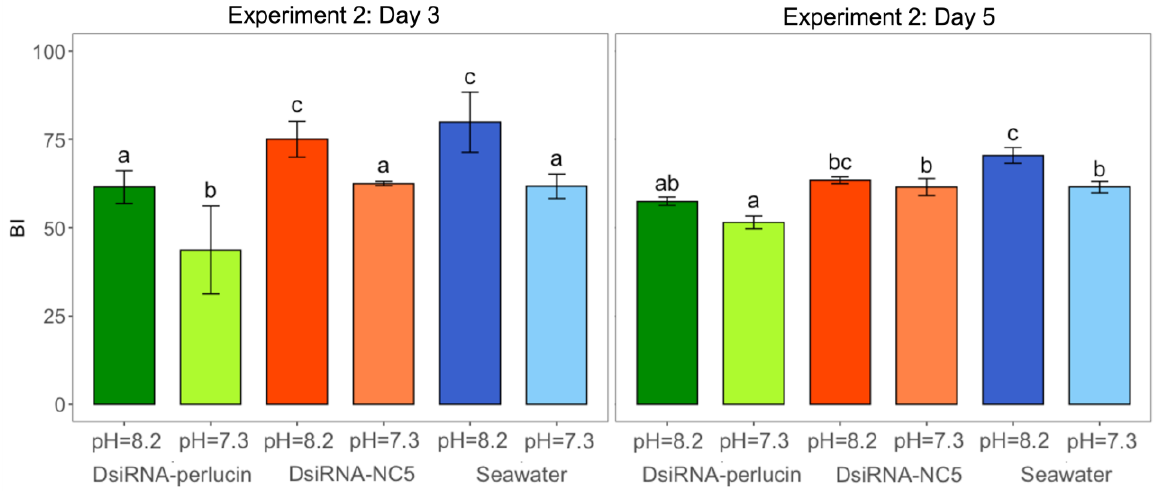
Figure 7. Shell birefringence index (BI, mean ± sd) among silenced (DsiRNA-perlucin (green)) and control (DsiRNA-NC5 (orange) and seawater (blue)) oysters cultured under different p CO 2 treatments (lighter shades for pH=7.3 and darker for pH=8.2) of oyster larvae from Experiment 2. BI was used as a proxy to measure biomineralization under cross-polarized light microscopy. Different letters (a, b, and c in each of Experiment 1 and 2) denote significant differences between treatments within each sampling day (nested ANOVA, n = 3, p -value < 0.05; Tukey post hoc tests).